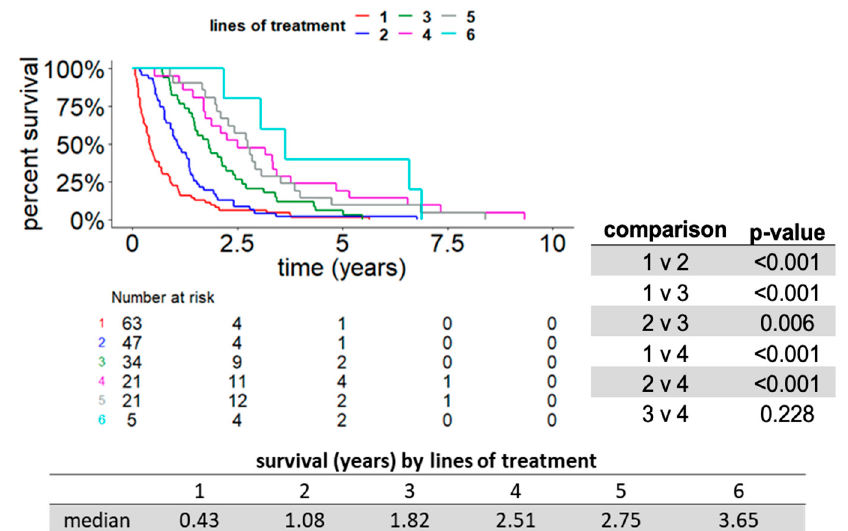
Figure 3. A greater number of total therapies received correlated with longer OS. Kaplan–Meier curves of OS are graphed. Patient cohorts in this figure are defined by the total number of treatment lines received (ranging from one to six). As only three patients received more than six lines of therapy, these patients were excluded. Subpanel: Pairwise statistical comparison of the length of OS between the four subgroups receiving one, two, three, and four lines of therapy.